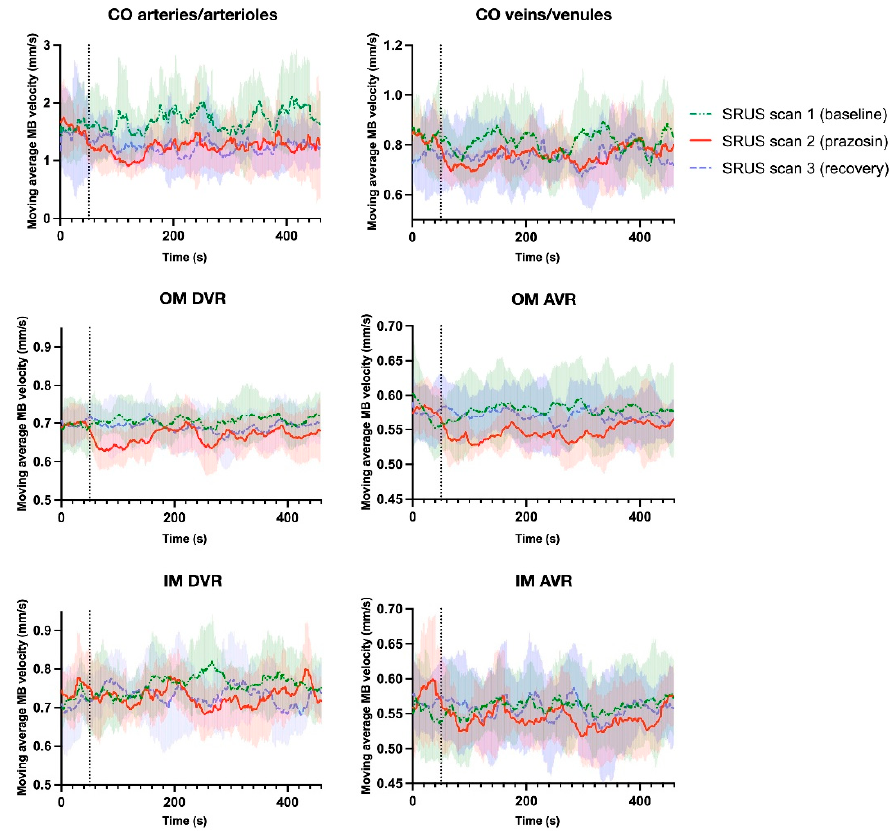
Figure 5. Moving average MB velocities in the arterial and venous beds of the cortex, outer medulla, and inner medulla during the three consecutive SRUS scans. The vertical dotted line indicates the time for prazosin injection. The semisolid colored areas are the standard deviations.